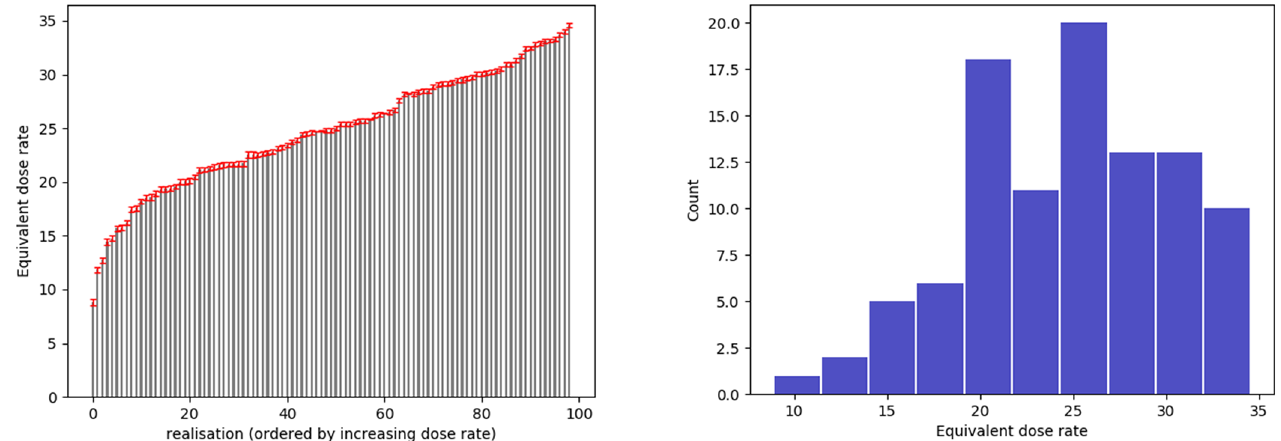
Fig. 11. 100 realizations of spherical inclusions with random radii, at a fi xed mass of 1g (left: realizations ordered by dose rate, with 2-sigma error bars in red and right: